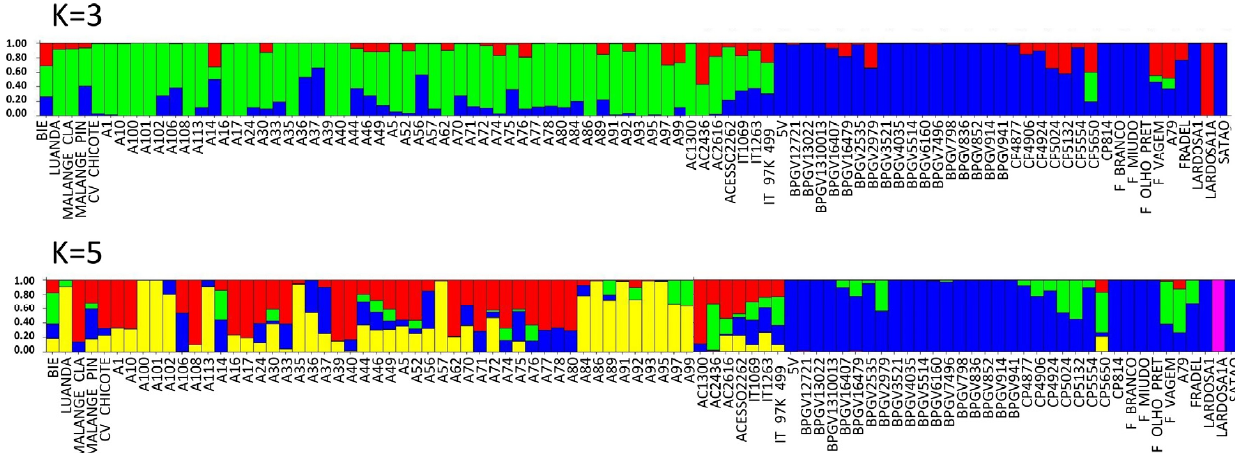
Figure 9. Population STRUCTURE of 92 cowpea accessions using SNP marker data as estimated using the model-based Bayesian algorithm implemented in the STRUCTURE program. Proportion of assignment of individuals to three and five population groups. Each accession is represented by a vertical line. The distribution of the accessions to different populations is indicated by the color code. In the blue right side are all the Portuguese accessions and on the other side are the PALOP samples. Vertical lines with only one color (higher than 80%) were considered pure accessions. Two landraces of Angola were pure (Luanda (yellow) and Malange Claro (red)).